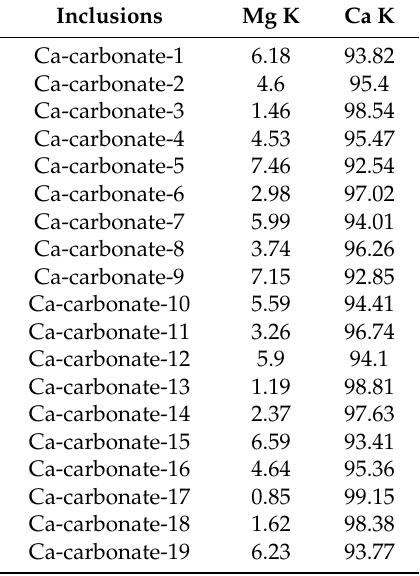
Table A4. Atomic ratios of Mg-Ca within carbonates formed by Ca . S. calcipolaris G9 grown in MS-2 medium for one